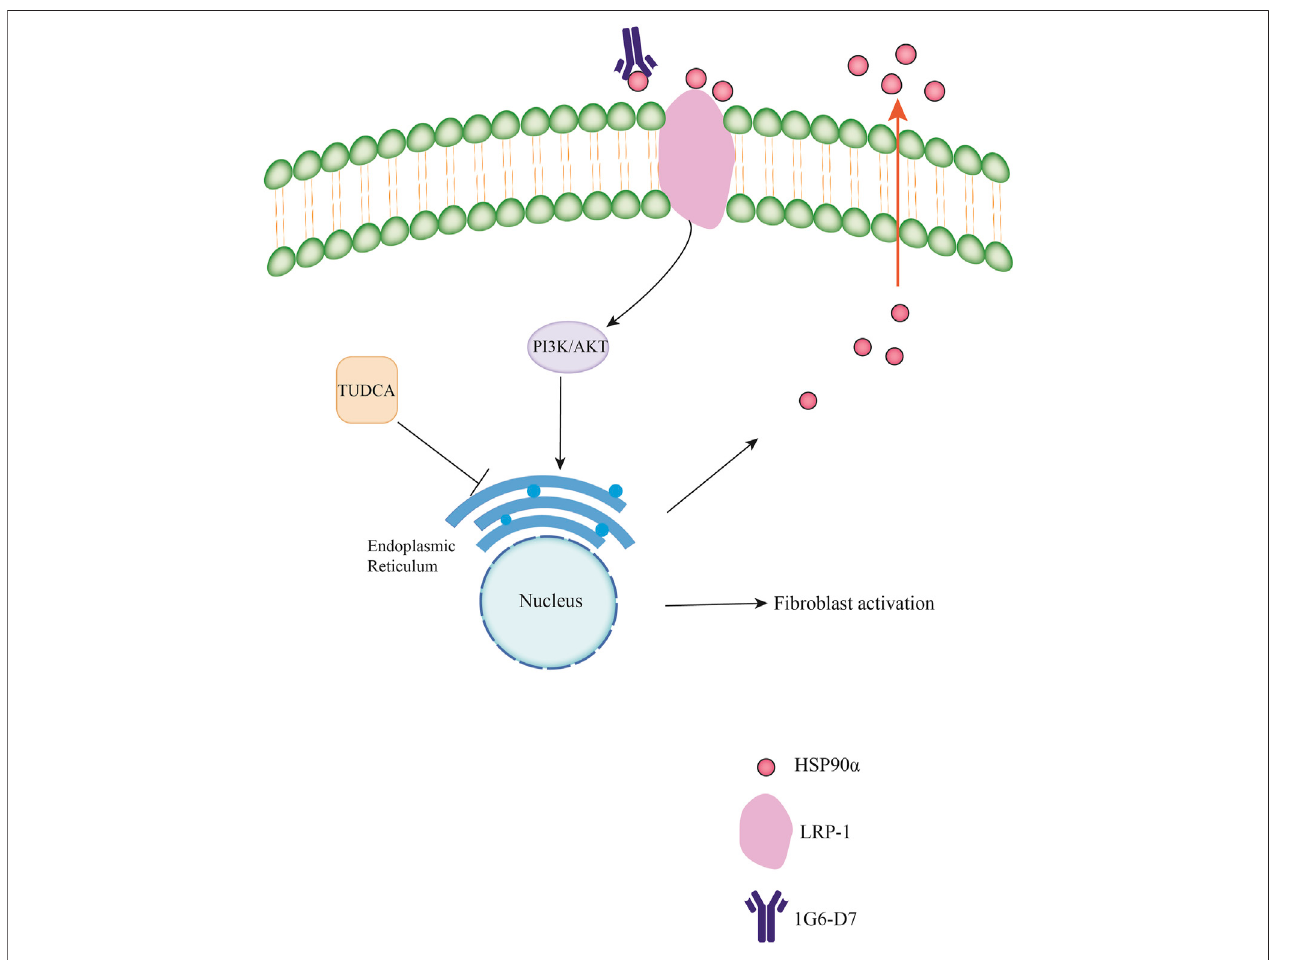
FIGURE 10 | Schematic diagram of the molecular mechanisms underlying the extracellular HSP90 α interacts with ER stress to promote fi broblasts activation through PI3K/AKT pathway in pulmonary fi brosis.